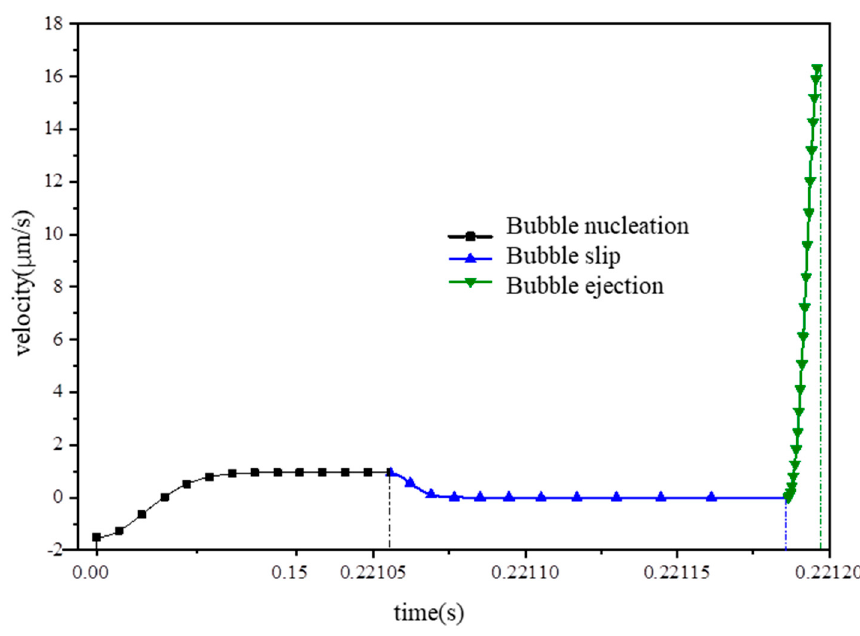
Figure 15. The velocity of the tubular micromotor in the stage of bubble nucleation, slip, and